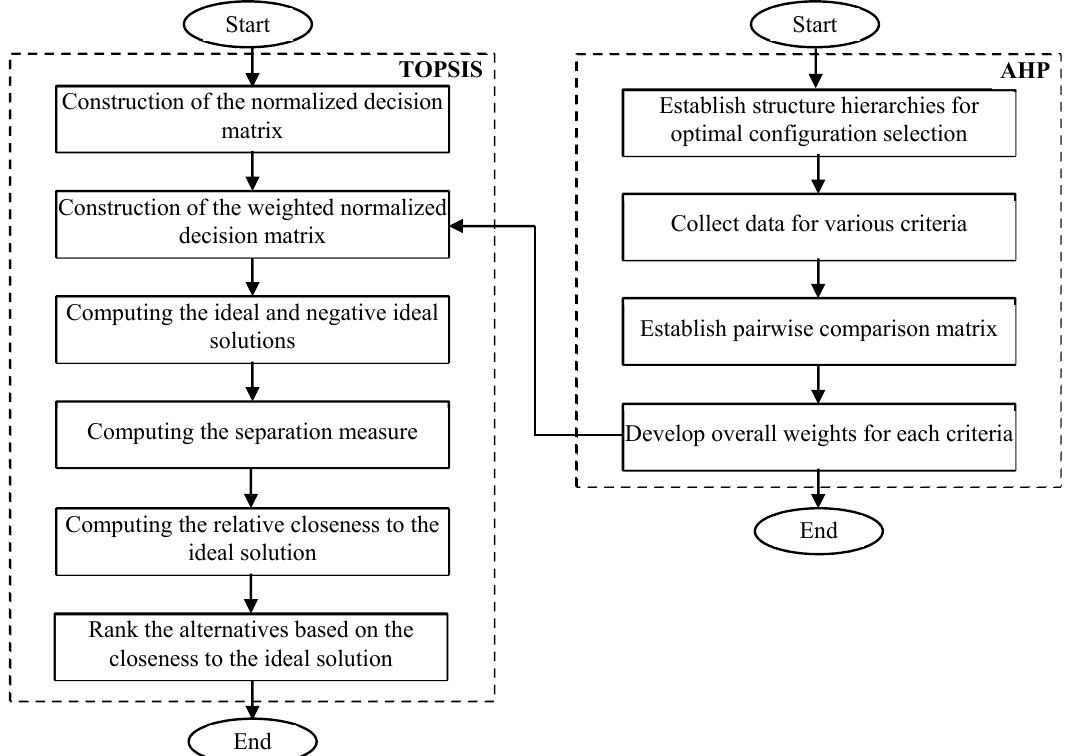
Figure 1. Integrated analytic hierarchy process - technique for order preferences by similarity to ideal solution (AHP-TOPSIS) model for selection optimal solution of load scheduling problem.